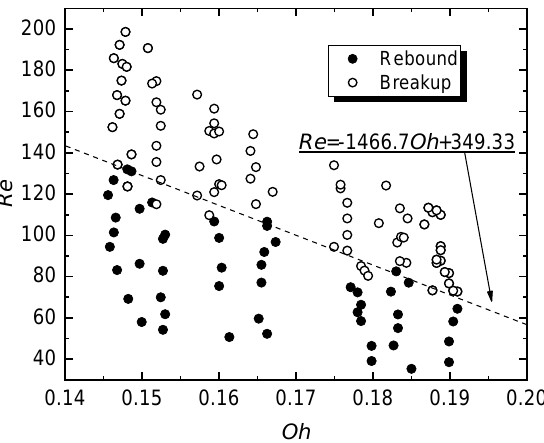
Figure 4. Hydrodynamic interaction regime map of a WiDME droplet and a heated surface as a function Re ( Oh ), T 0 = 320 °C.